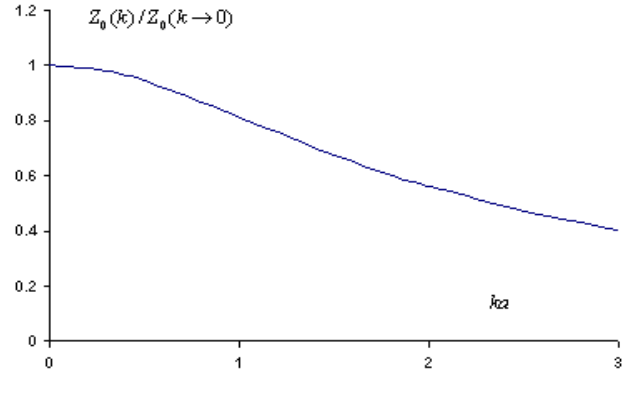
FIG. 22. (Color) Normalized wave impedance vs ka for a=b (cid:3) . 0 : 6 and " (cid:3) " 0